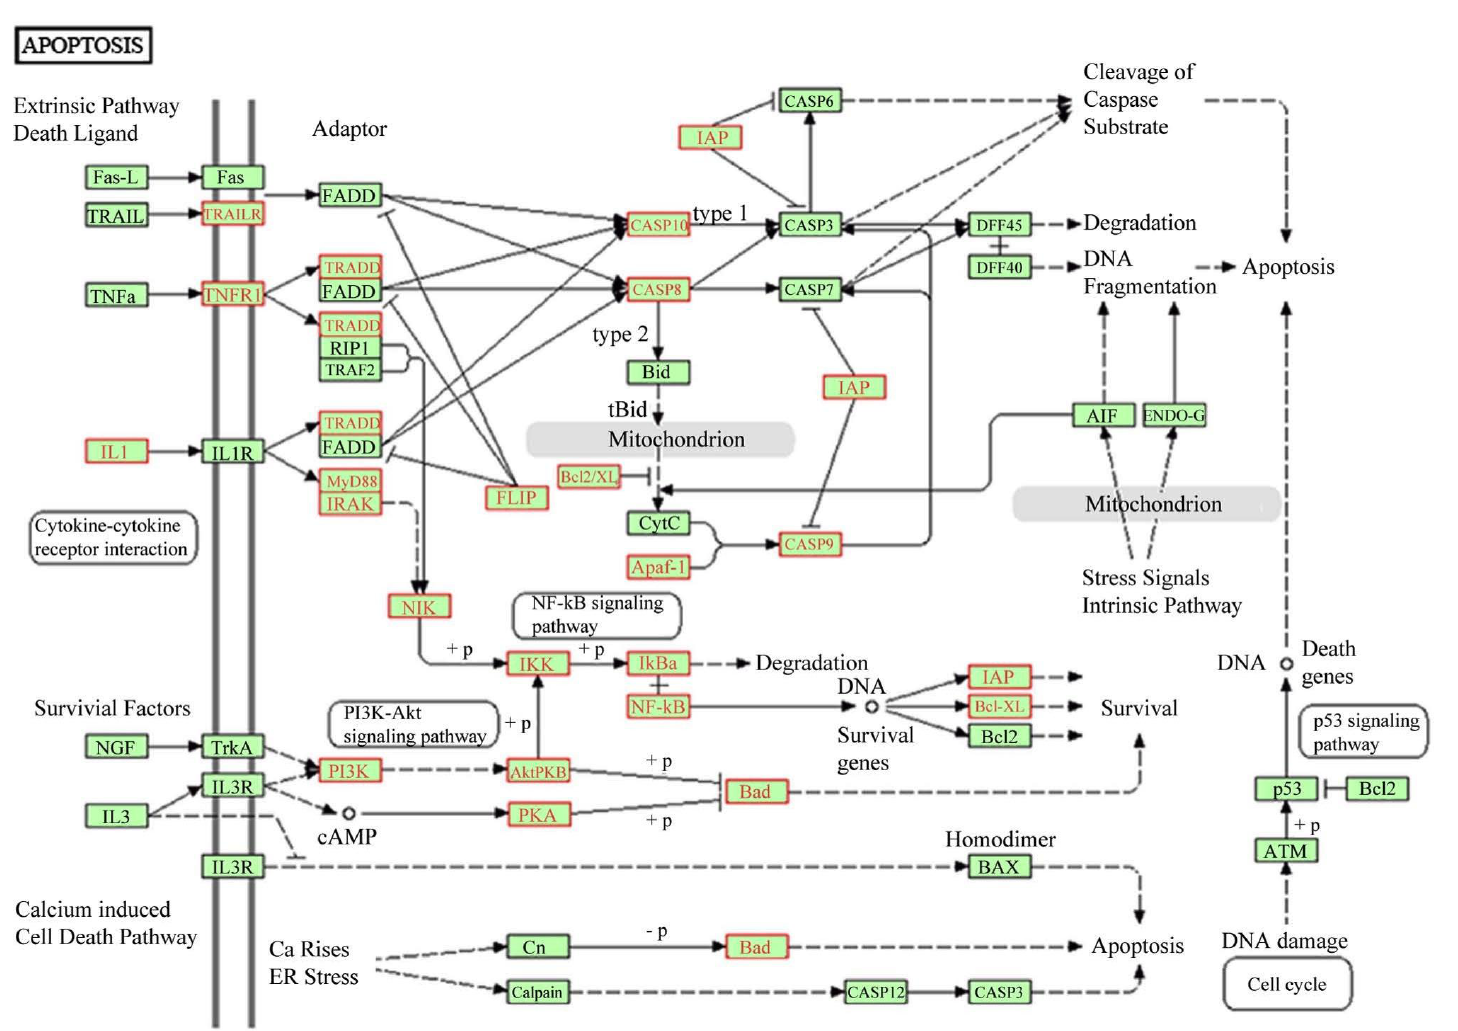
Figure 5. Scheme of apoptosis pathway according to KEGG database. In red are indicated genes altered after the treatment of A549 cells with SM30 NPs. According to Graphite web tool 32.5% of genes of the pathway were up-regulated after cell treatment (Supplemental Table